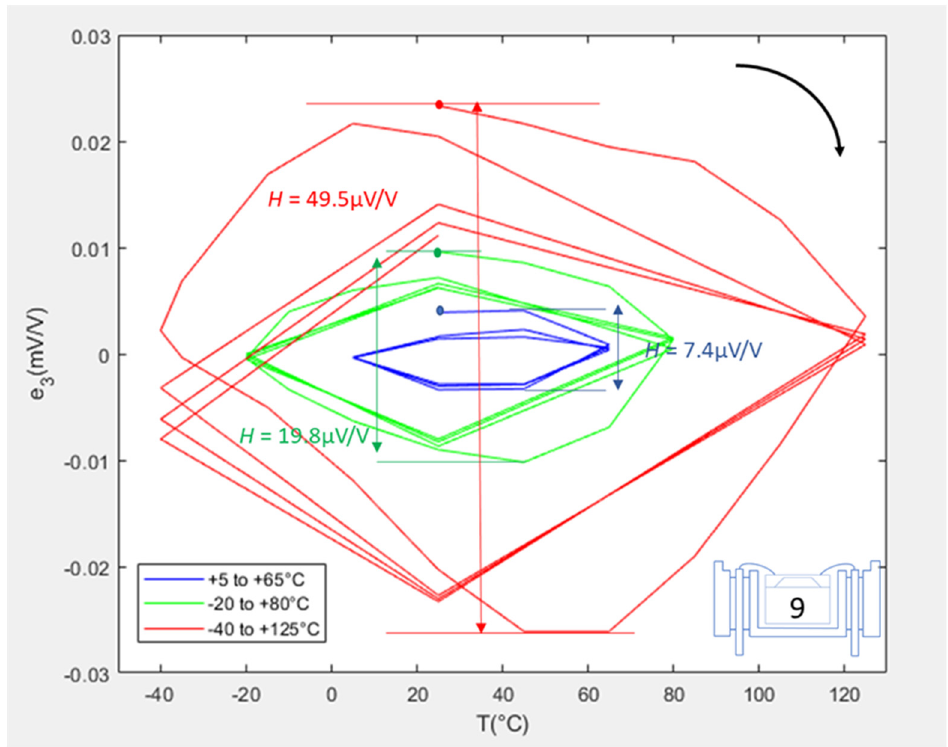
Figure 6. Error plots for SE #9 when L1-F packaged.